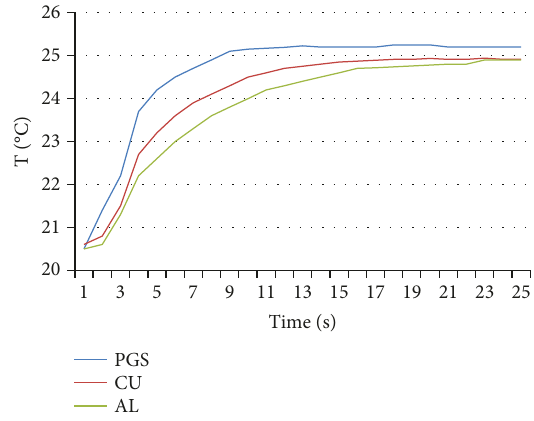
Figure 6: Temperature variation curves of the test.